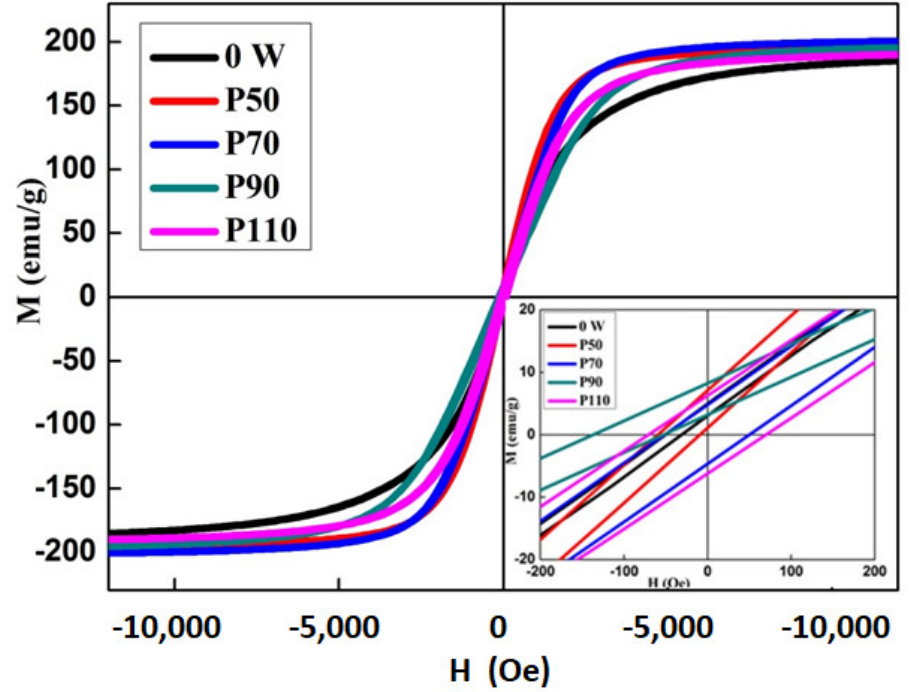
Figure 6. Hysteresis loops of the feedstock powders and selectively laser melted specimens.